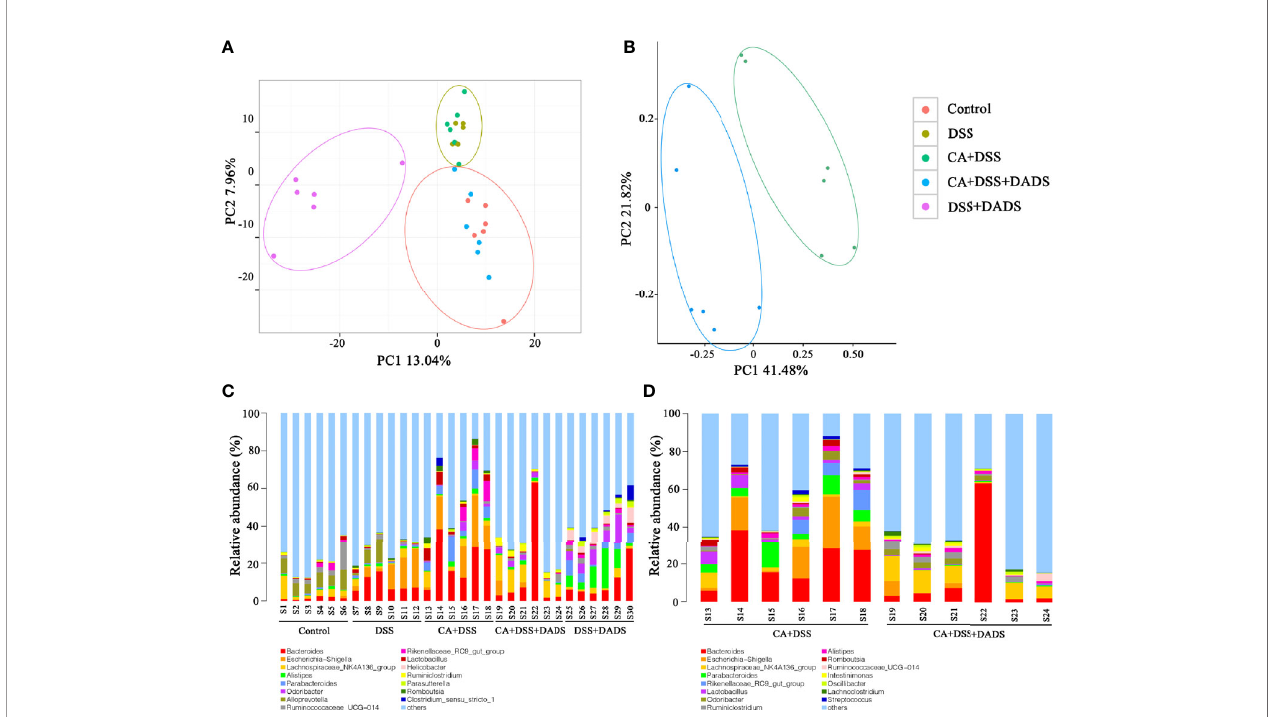
FIGURE 6 | DADS altered the gut microbiota community composition of mice with C. albicans infection. (A, B) Principal component analysis. (C, D) The relative abundances of the top 15 bacteria at the genus level among groups. * P < 0.05, ** P <